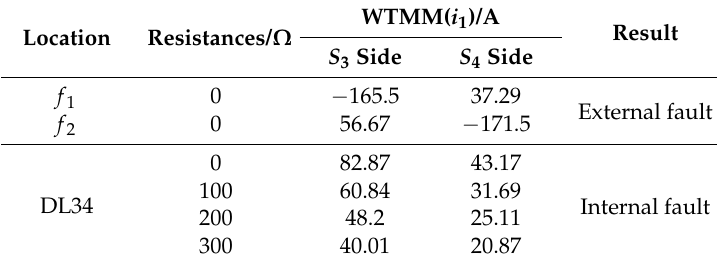
Table 3. WTMMs of 1-mode TW currents.